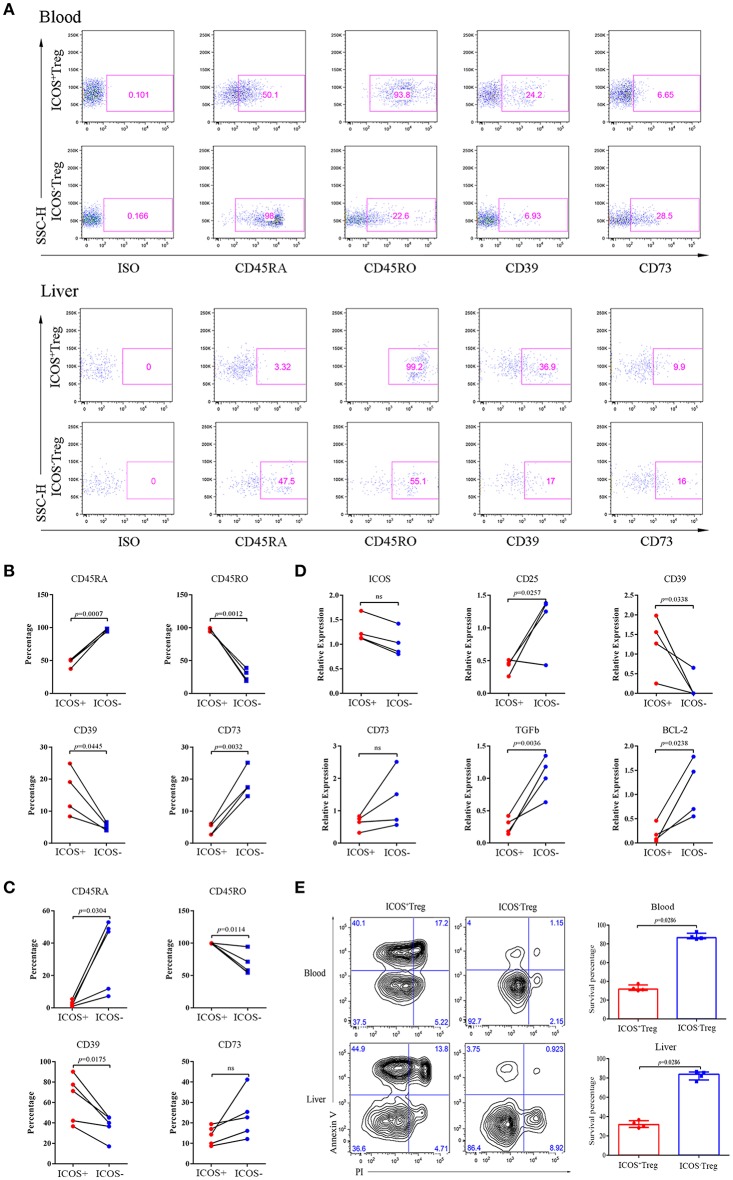
Phenotypes, RT-qPCR and apoptosis analyses of ICOS+Tregs and ICOS−Tregs. (A) Representative images of phenotypic expression of Treg subsets in peripheral blood (upper) and liver tissue (lower) from BA patients. Gates were set based on the ISO. (B,C) The statistical analysis of phenotypic expression of Treg subsets from peripheral blood (upper) and liver tissue (lower). Wilcoxon test was used. (D) RT-qPCR validation of ICOS, CD25, CD39, CD73, TGF-β, and BCL-2 genes were analyzed. Wilcoxon test was used. (E) Apoptosis Assay of Treg subsets from peripheral blood (upper) and liver tissues (lower) of BA patients. Mann-Whitney test was used.